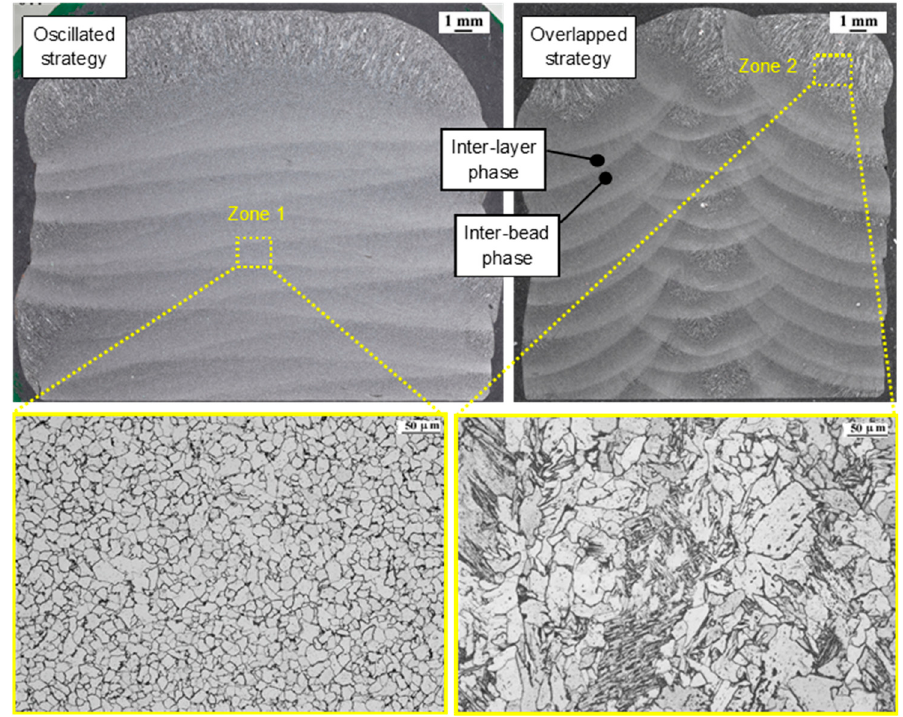
Figure 4. Macrographic images and microstructure of overlapped and oscillated walls manufactured by using GMAW technology with ER70.